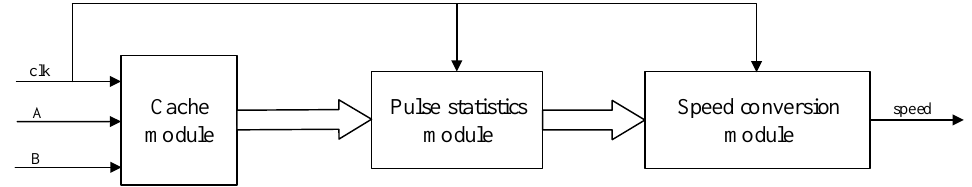
Figure 16. Design structure diagram of DC motor speed measurement module.